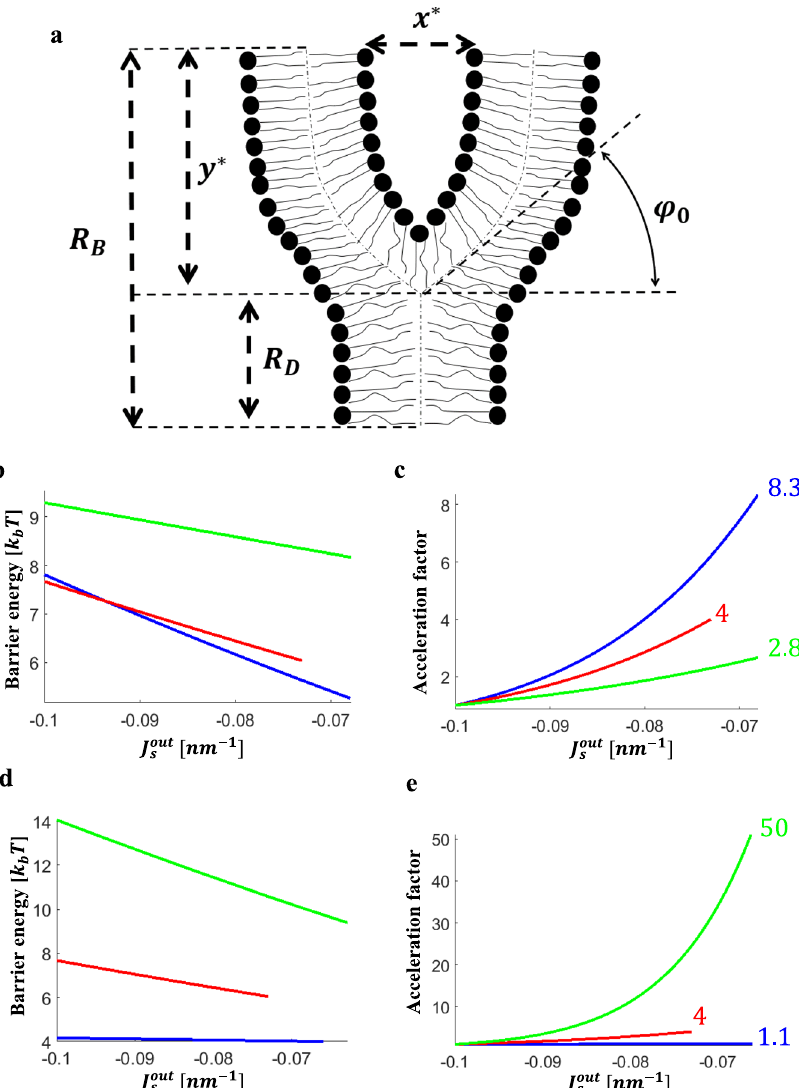
Fig. 2 Effects of fusion site dimensions on the energy barrier and the acceleration factor of the fusion pore formation. a Con fi guration of half-cross- section of the fusion site and notations. φ 0 - Junction angle, R D - diaphragm radius, R B - fusion site radius, x * - intermembrane distance, y * - the distance between the HD rim and the boundary of the fusion site. For simplicity, the relative dimensions are drawn out of scale. b , c Panels b and c describe the effects of varying the intermembrane distance, x * , on the energy barrier ( b ) and the acceleration factor ( c ), as a function of spontaneous curvature of the proximal monolayers. Blue line x * = 4.6 nm, red line x * = 6.6 nm, and green line x * = 8.6 nm. d , e Panels d and e describe the effects of varying fusion site radius, R B , on the energy barrier ( d ) and the acceleration factor ( e ), as a function of spontaneous curvature of the proximal monolayers. Blue line R B = 10 nm, red line R B = 15 nm, and green line R B = 20 nm. The parameter values used in all panels are l = 1.5 nm, κ m = 10 k b T, (cid:1) κ m ¼ (cid:2) 5 k b T , λ = 10 pN. The radius of the fusion site in b and c is R B = 15 nm and the intermembrane distance in panels d and e is x * = 8.6 nm. We indicate in c and e the acceleration factor for the maximal calculated LPC area fraction in the proximal monolayers, ϕ LPC . c Blue line, x * = 4.6 nm, ϕ LPC = 10%, β = 8.3. Red line, x * = 6.6 nm, ϕ LPC = 7.5%, β = 4. Green line, x * = 8.6 nm, ϕ = 10%, β = 2.8. e Blue line, R = 10 nm, ϕ = 10%, β = 1.1. Red line, R = 15 nm, ϕ = 7.5%, β = 4. Green line, R = LPC B B LPC B LPC 20 nm, ϕ LPC = 10%, β =